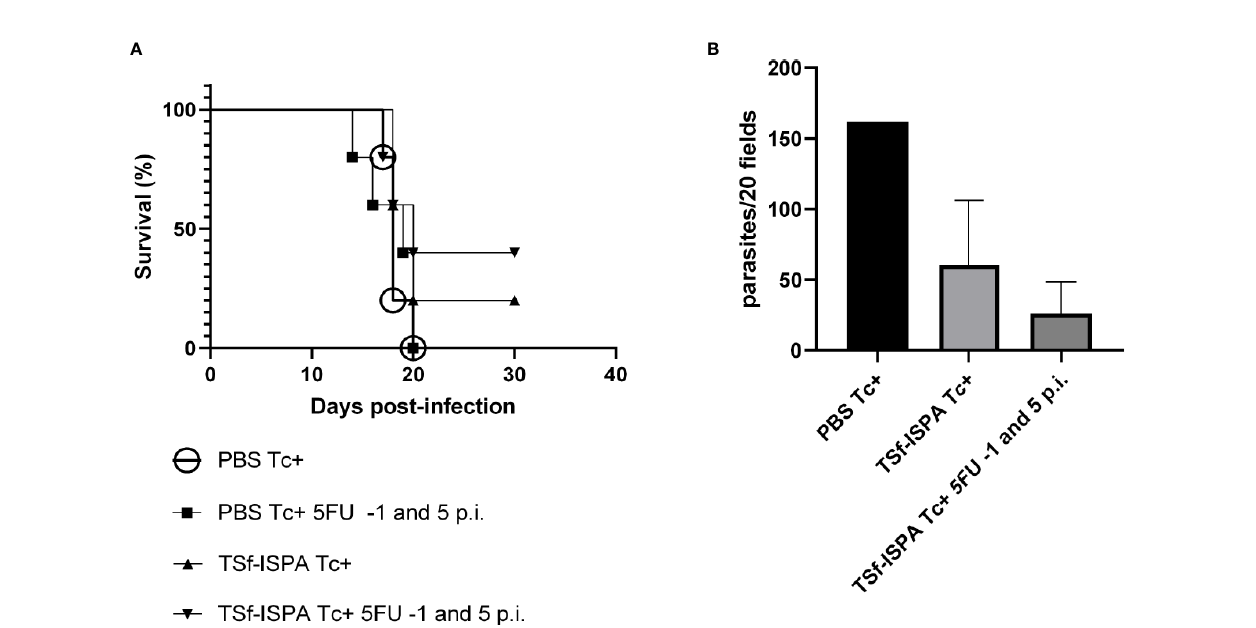
FIGURE 6 | 5FU treatment at day -1 and 5 p.i. and the protective capacity of TSf-ISPA vaccine. Mice immunized with TSf-ISPA or PBS were treated or not with 5FU at day -1 and 5 p.i. and challenged with 1500 trypomastigotes of the Tulahuen strain. (A) Survival rates are shown for PBS-inoculated and infected mice (PBS Tc+), PBS Tc+ treated with 5FU at day -1 and 5 p.i. (PBS Tc+ 5FU -1 and 5 p.i.), TSf-ISPA immunized and infected mice (TSf-ISPA Tc+) and TSf-ISPA Tc+ treated with 5FU at day -1 and 5 p.i (TSf-ISPA Tc+ 5FU -1 and 5 p.i.); (B) Parasitemia at day 20 p.i. of PBS Tc+, TSf-ISPA Tc+ and TSf-ISPA Tc+ 5FU at day -1 and 5 p.i. (PBS Tc+ 5FU -1 and 5 p.i. mice were dead at day 20 p.i.) Data are expressed as means + standard deviations. The results are representative of two independent experiments (n=5 mice per